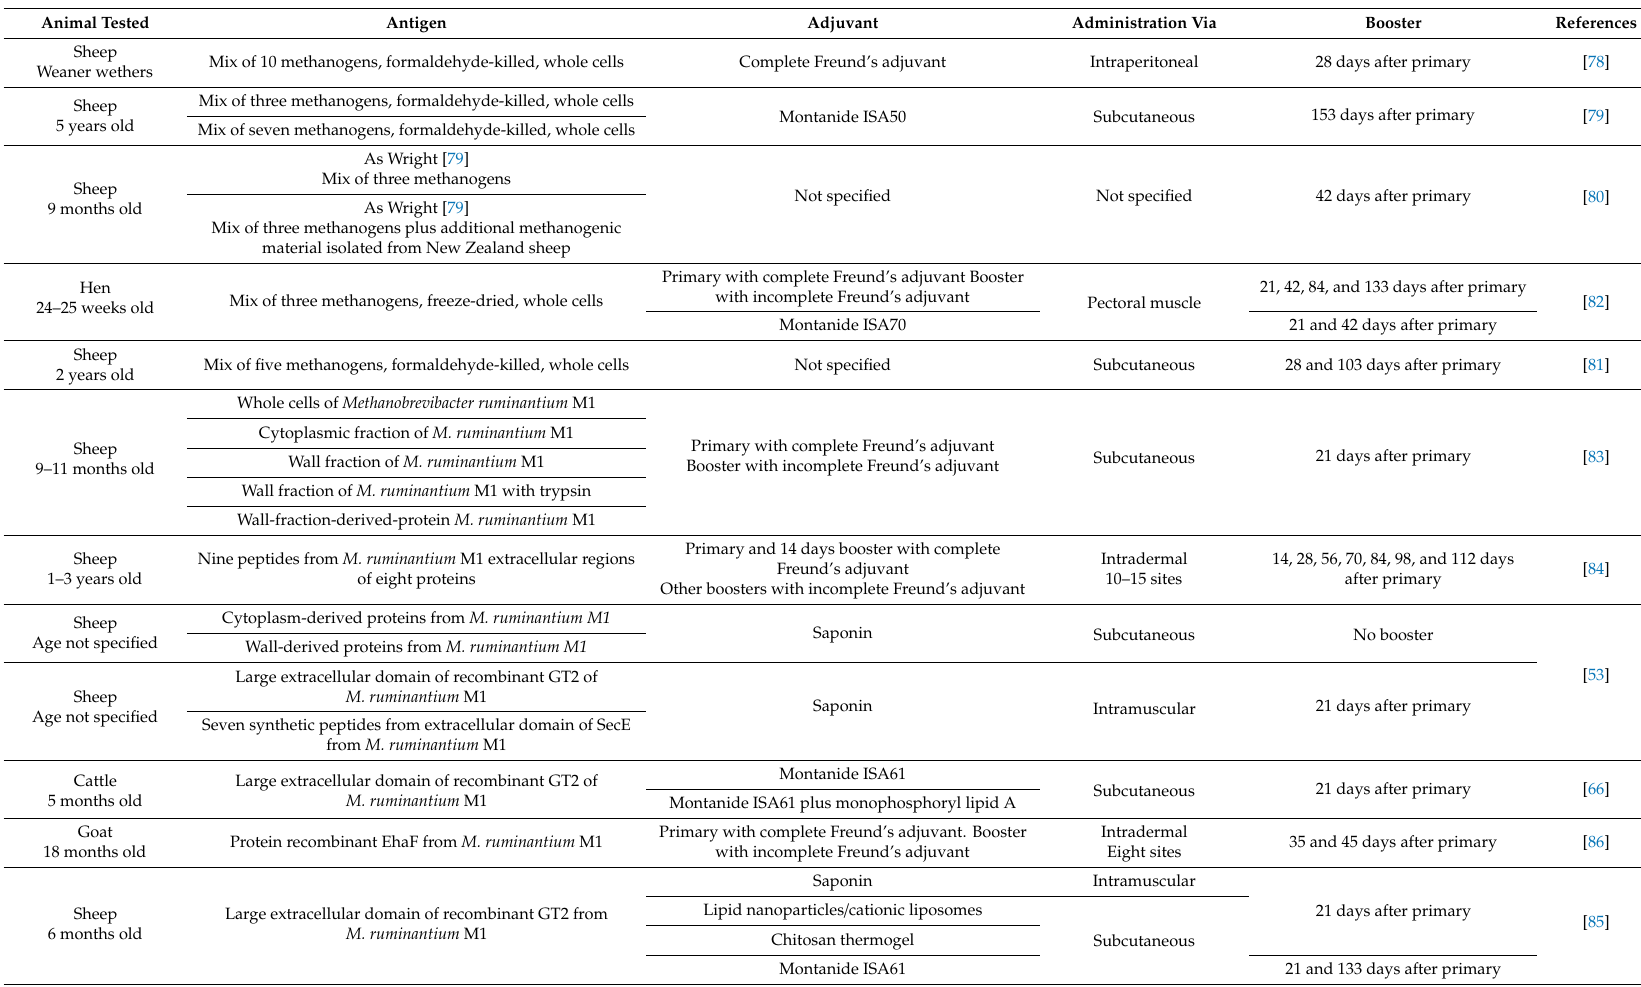
Table 1. Summary of experimental designs used in research into vaccination for mitigating methane in ruminants. Animal